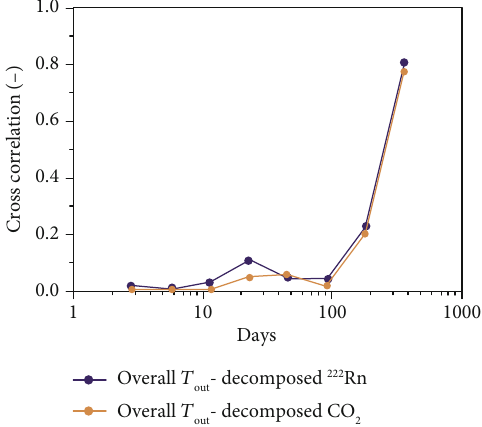
Figure 8: Cross-correlation function between outdoor temperature and decomposed 222 Rn and CO at di ff erent multiresolution 2